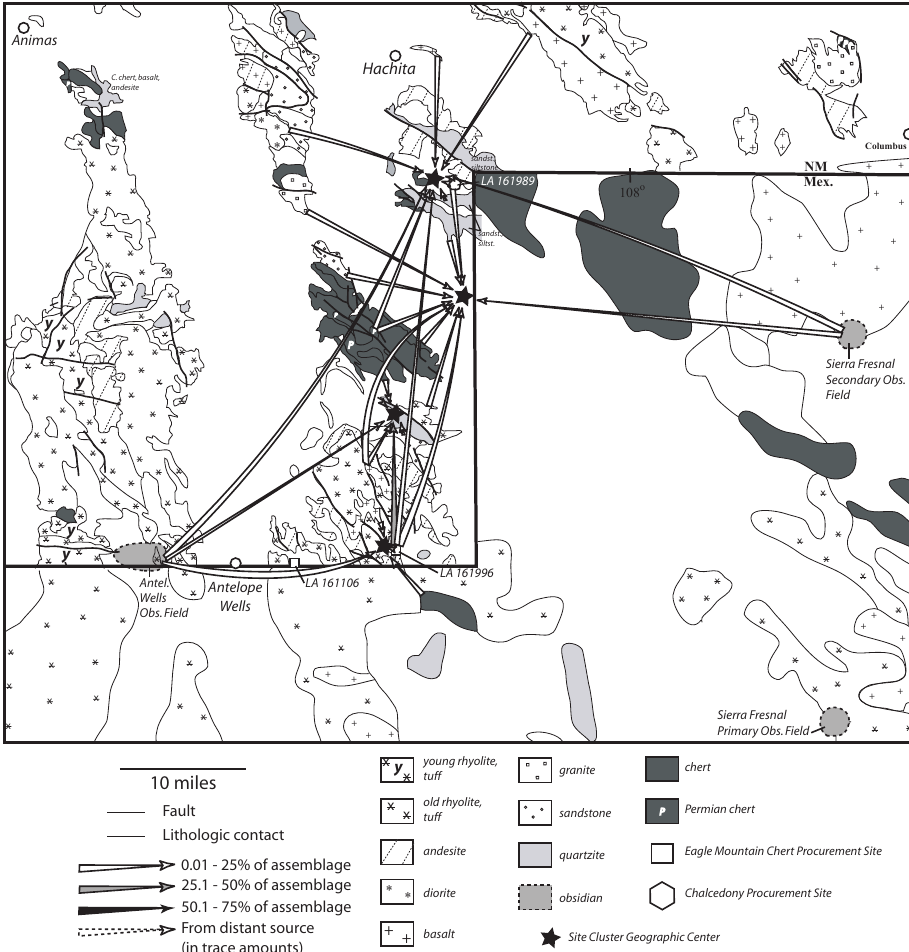
Fig. 5. Geologic map of the Boot Heel of southwestern New Mexico with locations of site clusters and minimum distance movement of geologic materials for sites identified as